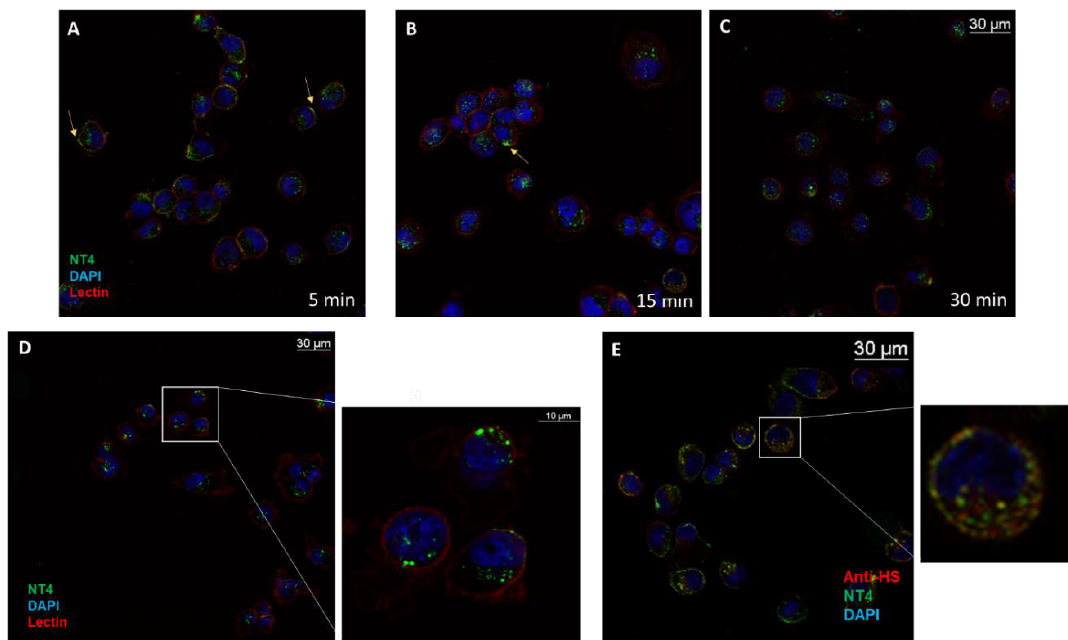
Figure 1. NT4 binds the plasma membrane of MDA-MB-231 and is internalized within 30 min. ( A ) After 5 min, part of the NT4 green signal is on the membrane (yellow arrow); ( B ) after 15 min, the membrane-bound portion of the peptide has decreased; ( C ) after 30 min, most of the peptide is inside the cell, localized in endosomes ( D ); ( E ) anti-HS antibody colocalizes with NT4 on the membrane and in endosomes.